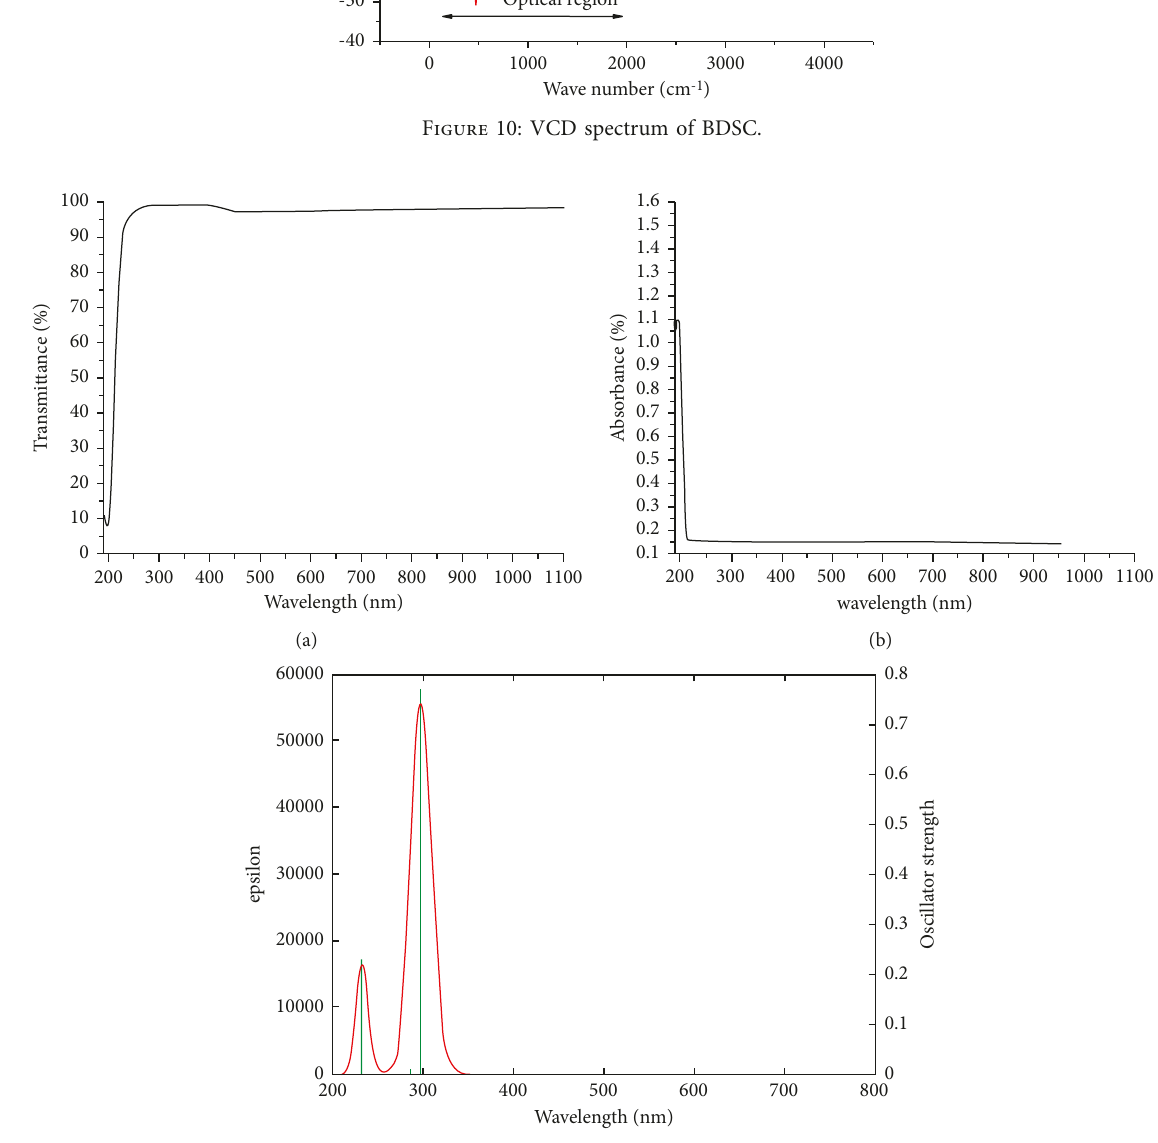
Figure 11: (a) UV-Vis transmittance. (b) UV-Vis absorption spectrum of BDSC spectrum of BDSC. (c) Theoretical UV spectra of